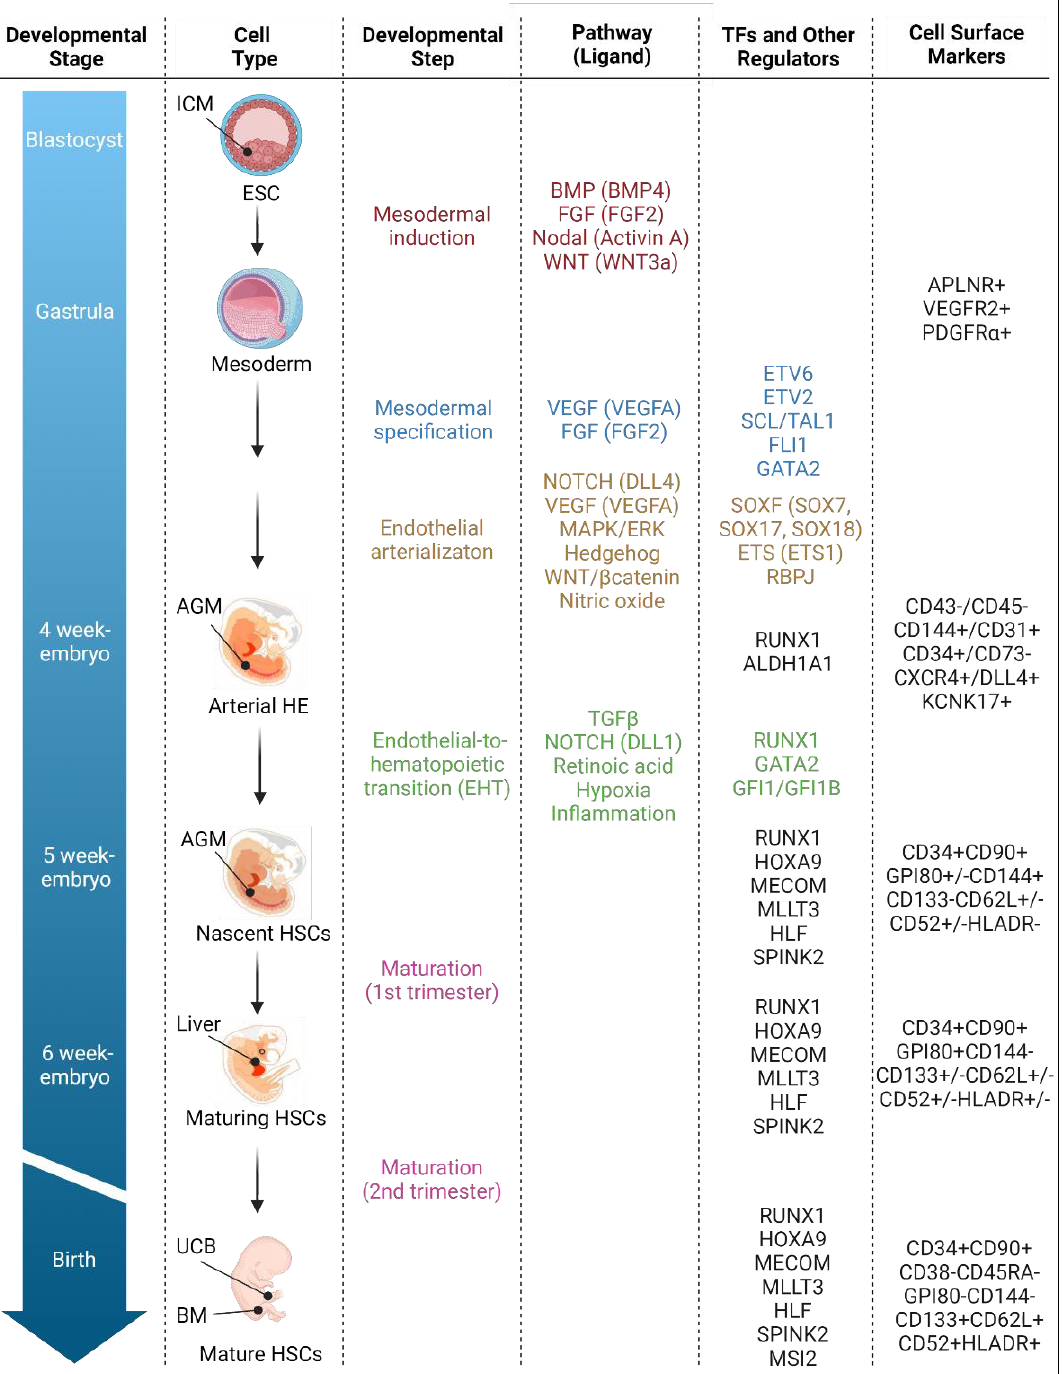
Figure 2. Human hematopoietic developmental process . Specification of hematopoiesis from ESCs occurs through stages of mesodermal induction, hematoendothelial specification, vascular arterialization, endothelial-to-hematopoietic transition and HSC maturation during development. Key intrinsic regulatory networks and cell surface epitopes mark each developmental step in vivo. Most approaches for de novo generation of HSCs from PSCs attempt to recapitulate in vitro the process that occurs during embryonic and fetal development. Abbreviations: AGM: